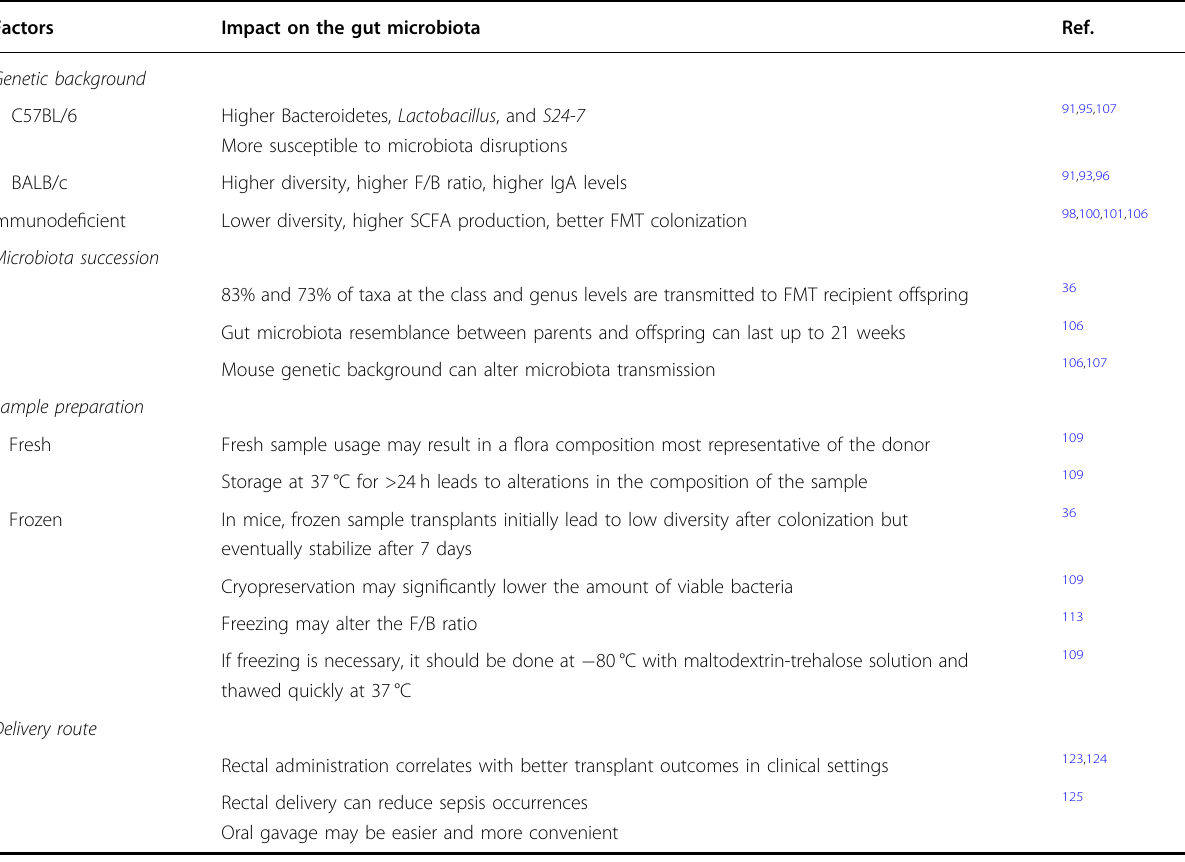
Table 2 Factors affecting microbiota colonization in humanized murine gut fl ora models.